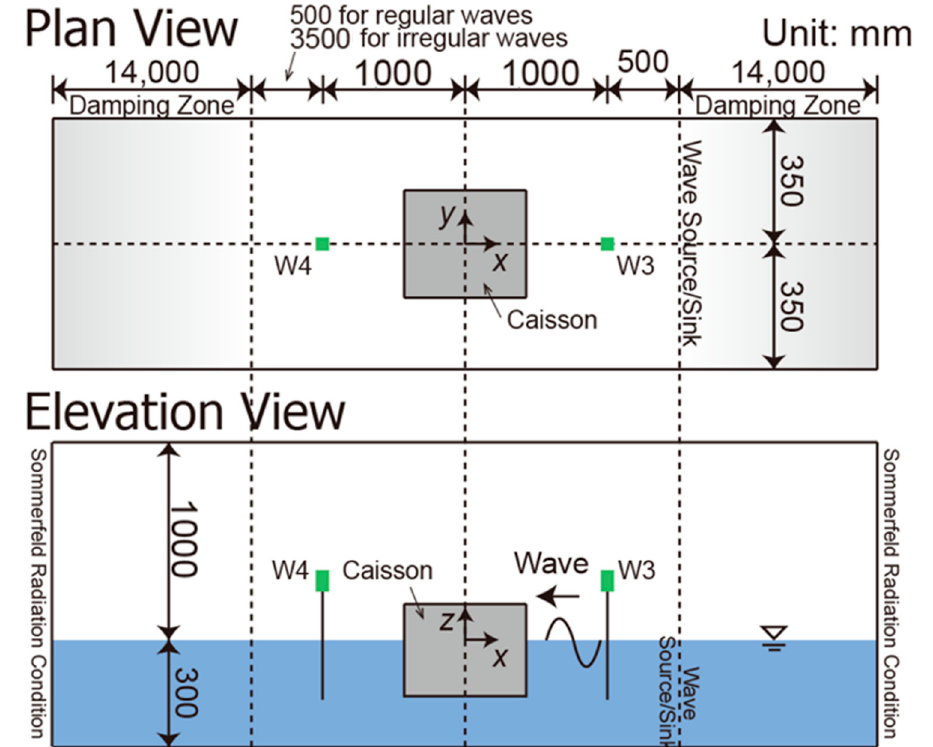
Figure 12. Computational domain (unit: mm; W3, W4: output locations of water surface fluctuations).